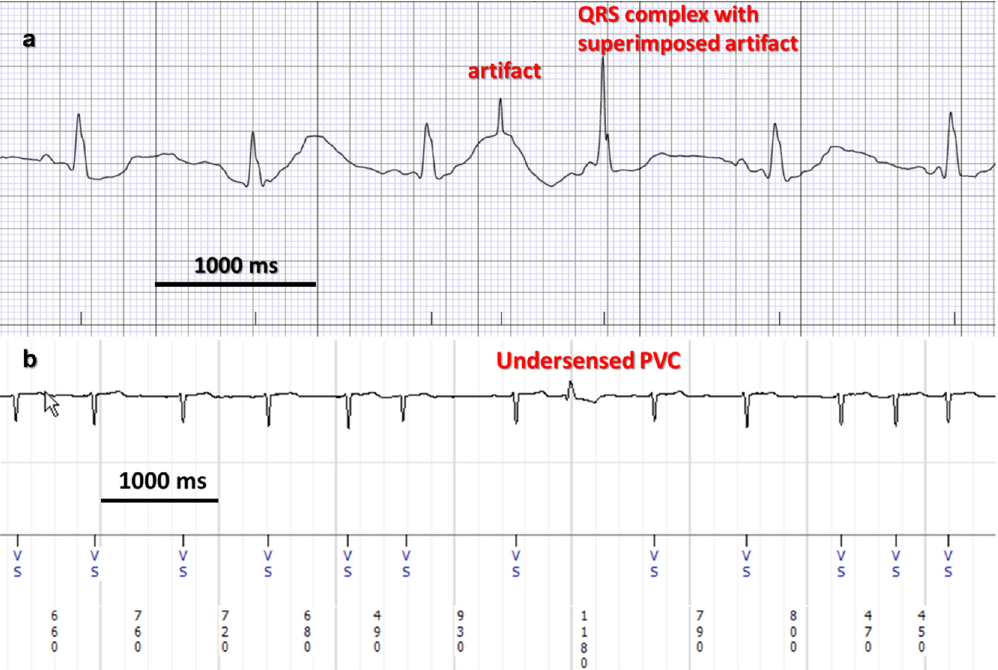
Figure 1. Electrocardiographic recordings of heart activity. ( a ) consumer grade heart rate monitor (AliveCor Kardia). The algorithm detects the QRS intervals and transforms them into markers. An inappropriately marked artifact is seen (non-physiological signal, no repolarization). These findings are easily detected and rejected by trained human interpreters but remain challenging for automated rhythm analysis. ( b ) Implantable cardiac rhythm monitor (Medtronic Reveal Linq). These devices benefit from improved signal/noise ratio due to the subcutaneous position of the device, close to the heart. However, sensing issues are still not infrequent, such as in this patient with atrial fibrillation and an undersensed premature ventricular contraction (PVC).